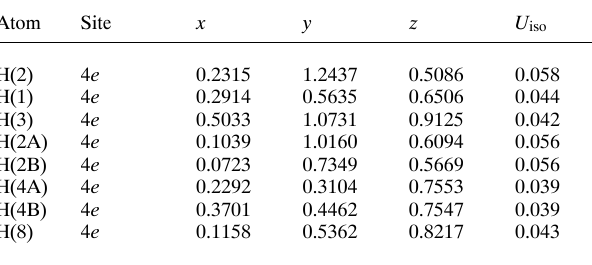
Table 2. A tomic coordin a tes a nd displ a cement p a r a meters (in Å 2 )